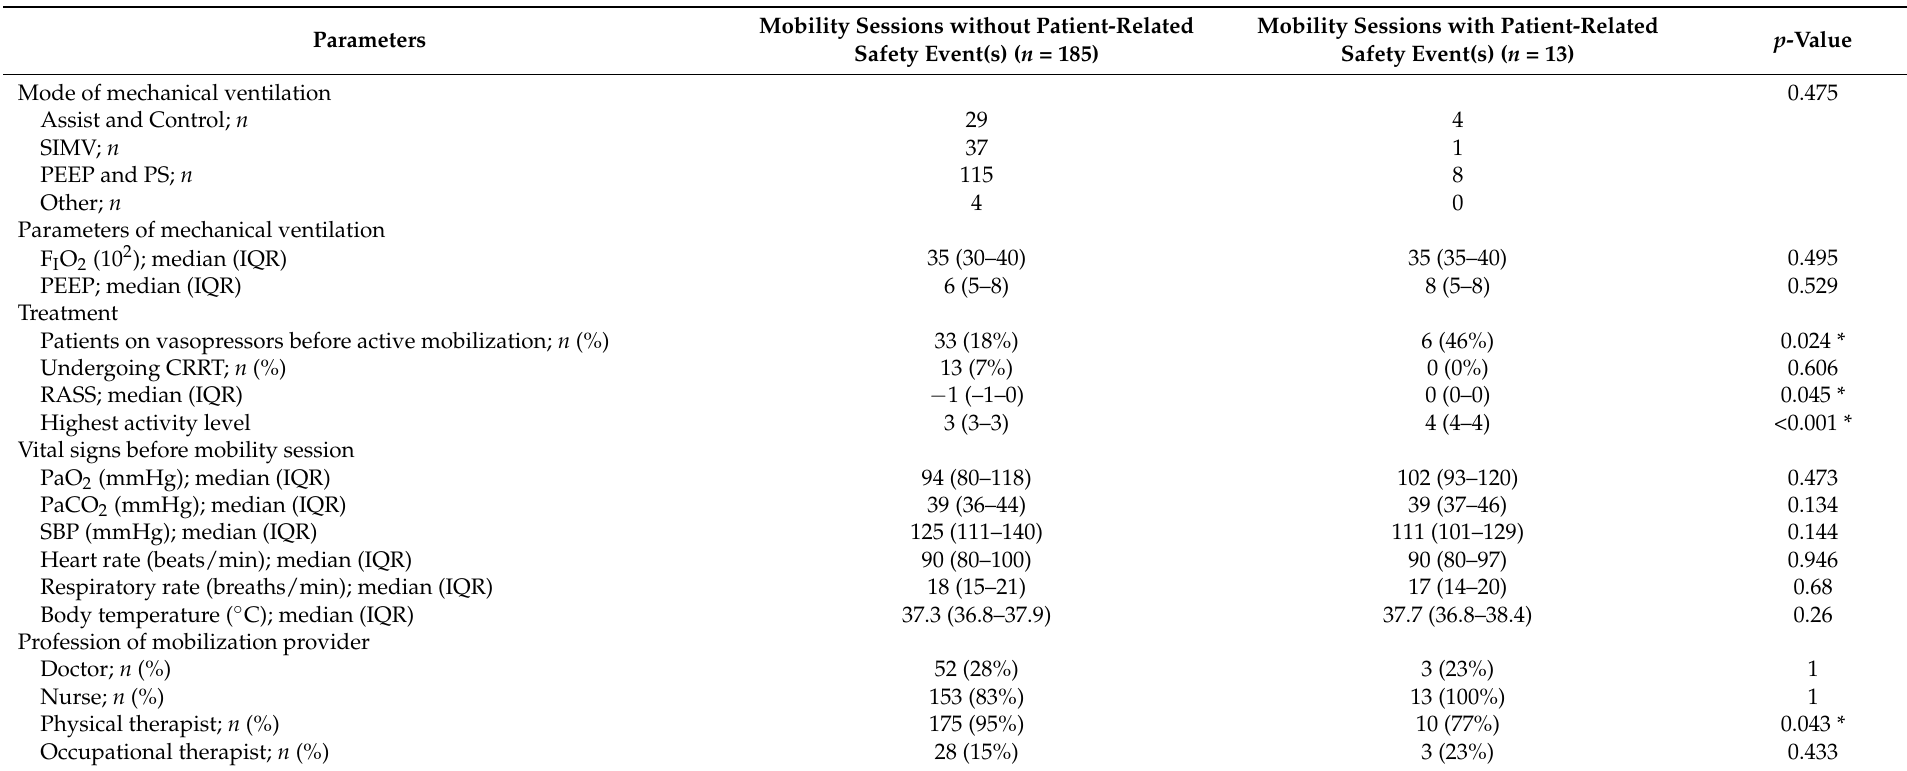
Table 2. Comparison of mobilization sessions with and without patient-related safety